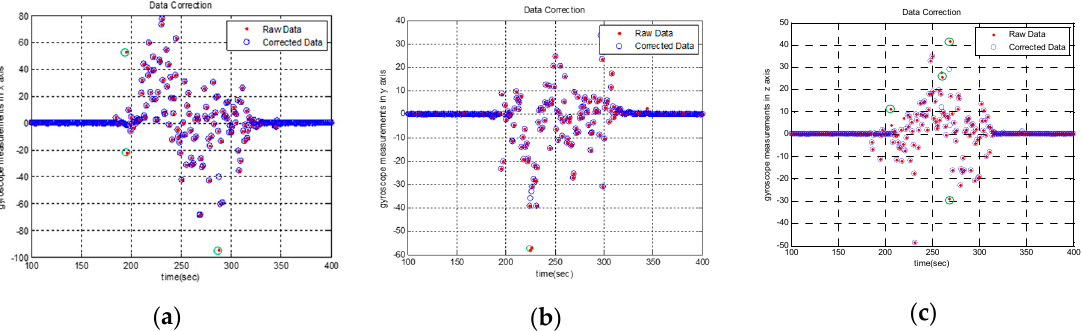
Figure 4. Show of gyroscope raw data and the corrected data by applying first-order differential data processing algorithm: ( a ) gyroscope measurements in x axis; ( b ) gyroscope measurements in y axis; ( c ) gyroscope measurements in z axis.